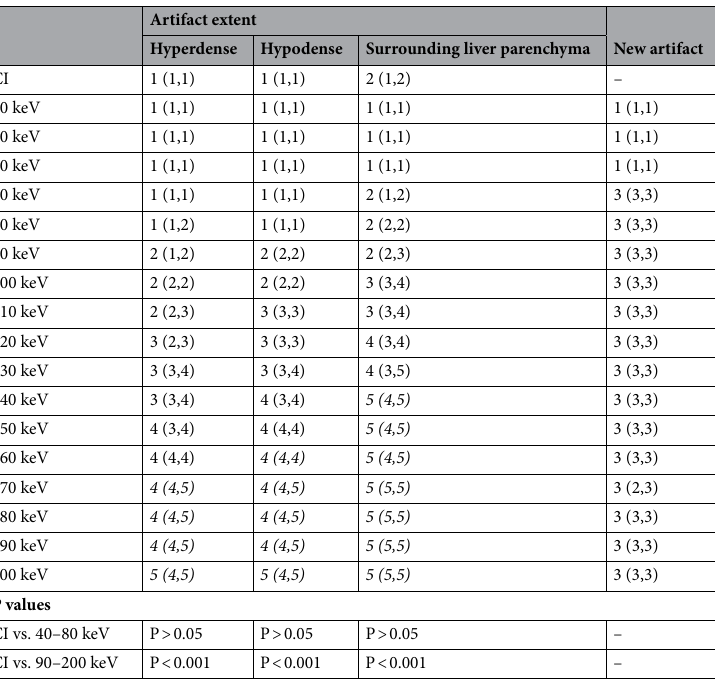
Table 1. Qualitative assessment of artifact reduction and surrounding liver parenchyma. CI conventional images. Data in italics indicate no statistical significance between any two energy levels.